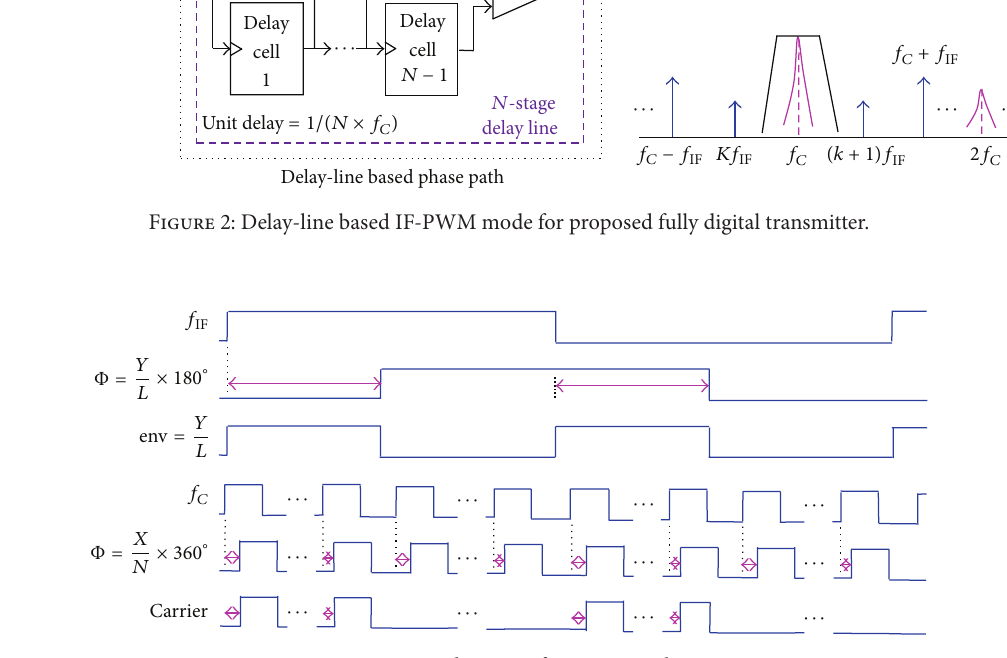
Figure 3: Function diagram of IF-PWM